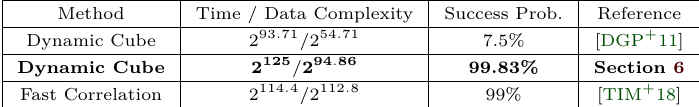
Table 1: Summarize all available attacks on full